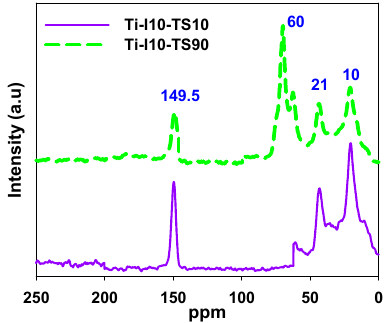
Figure 7. The 1 H- 13 C CP-MAS NMR spectra for the Ti-I10-TS10 and Ti-I10-TS90 samples.